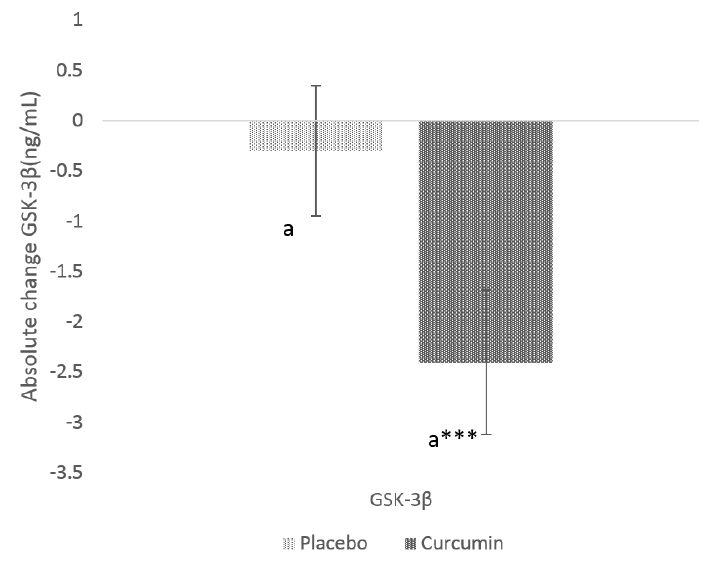
Figure 1. Absolute change in serum glycogen synthase kinase – β (GSK-3 β ) from baseline to post-intervention in placebo and curcumin groups for 12 weeks. *** p < 0.001 represents the difference within the treatment group. Small letter (a) represents the significant difference between the treatment groups. Nutrients 2020 , 12 , x FOR PEER REVIEW